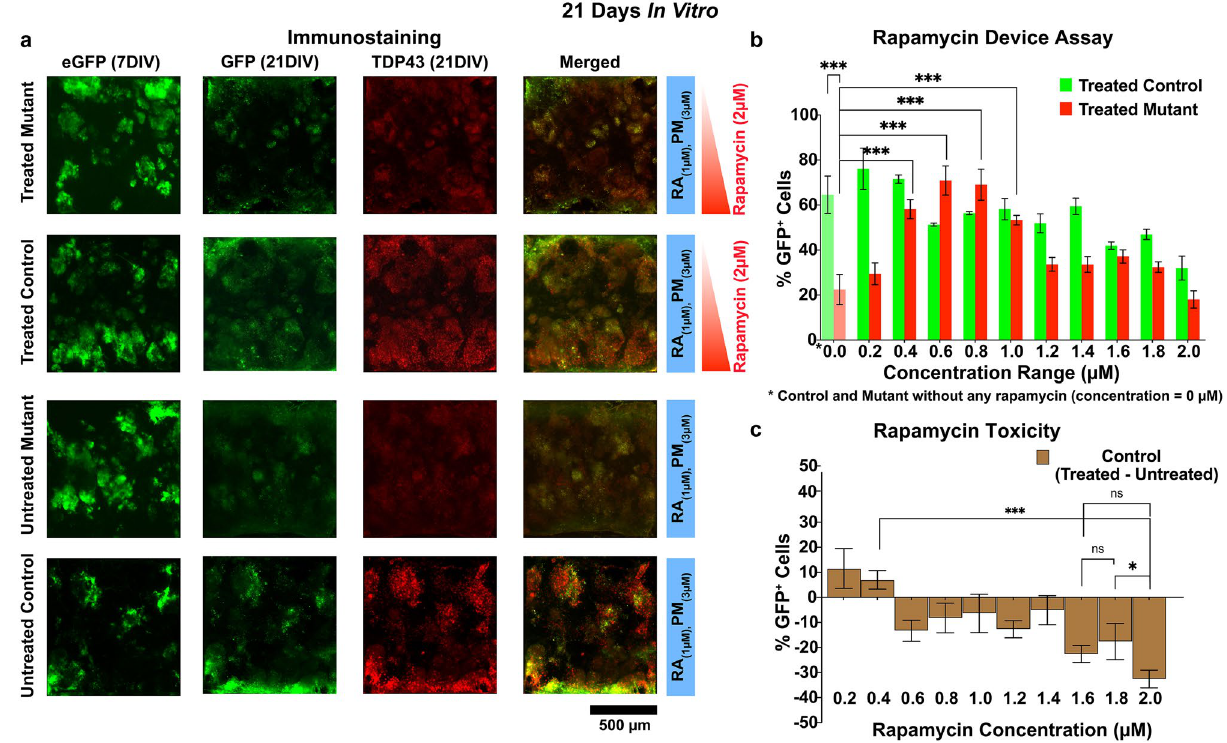
Figure 7. Rapamycin assay in microdevice (21DIV). ( a ) Typical microdevice immunostaining for GFP and TDP-43 at 21 DIV under a rapamycin gradient. Red sidebars immediately to the right indicate the spatial direction of the rapamycin gradient (red: 0–2 µM), while the blue bars indicate a constant concentration of culture media morphogens. ( b ) Plots the average (n ≥ 4) percent viability of rapamycin treated MNs (GFP + ) i.e. viability of treated mutant MNs (red) and treated control MNs (green) as a function of rapamycin concentration. *Indicates both mutant and control MNs which are not exposed to rapamycin, i.e. untreated MNs respectively. ( c ) Shows the relative MN toxicity of rapamycin on control MNs, i.e. The percent viability of rapamycin treated control MNs minus the average viability of rapamycin untreated control MNs. A positive ( +) value indicates an increased survival of control MN’s without rapamycin and a negative (−) value indicates a toxicity effect of rapamycin. P values: Non significant (ns) P > 0.05, *P ≤ 0.05, **P ≤ 0.01, ***P ≤